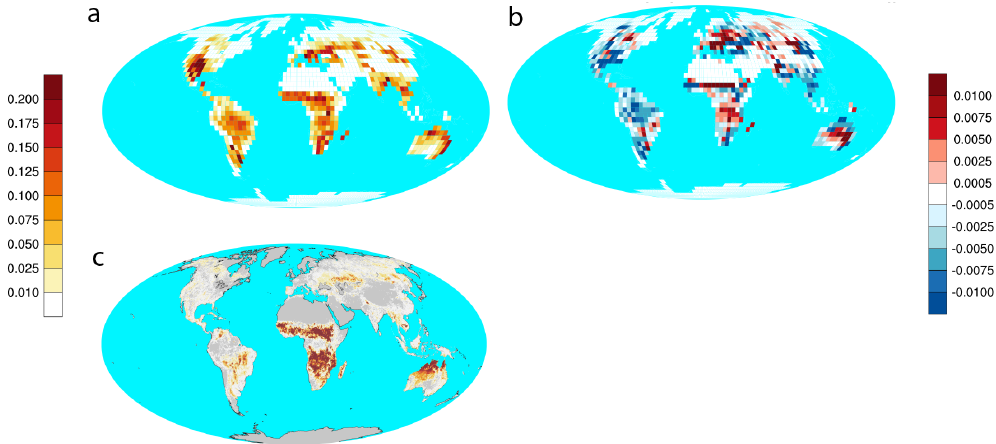
Figure 1. Simulated annual burned fraction of grid cell area [m 2 m − 2 ] of natural fire activity for 8000calyrBP (a) and differences between 8000 and 200calyrBP (7900–7999 minus 100–199) (b) . Panel (c) shows the burned area based on present-day satellite observations as reported in GFED4 (Giglio et al., 2013).